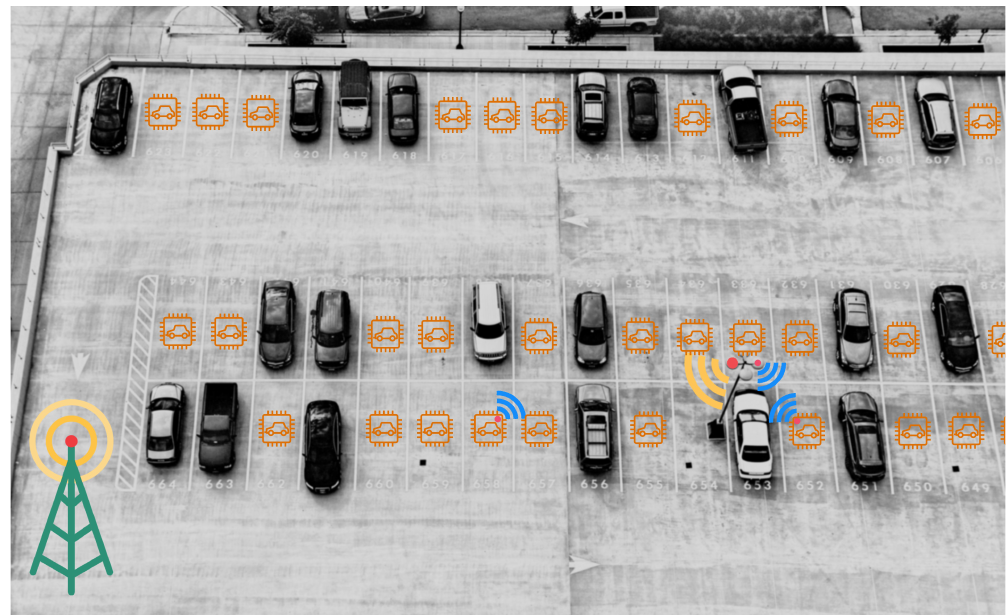
Figure 1. Use case of proposed system in a typical parking scenario. The nRF and LoRa communication are shown in blue and yellow,